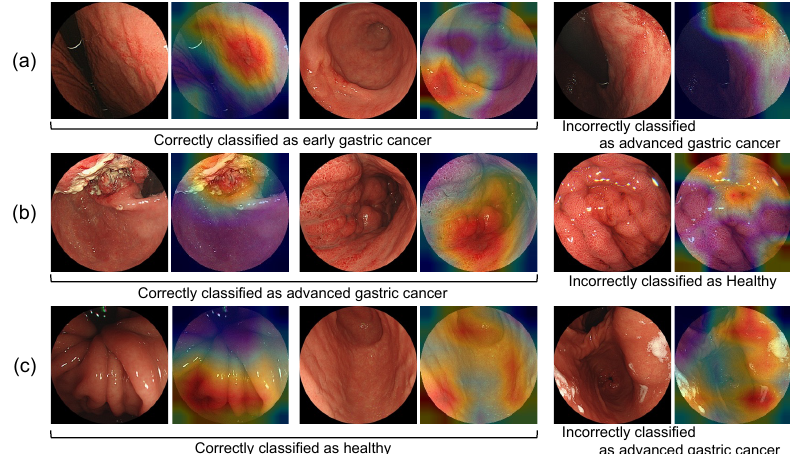
Figure 5. Correctly and incorrectly classified images: ( a ) classification results of early gastric cancer; ( b ) classification results of advanced gastric cancer; ( c ) classification results of healthy subjects.